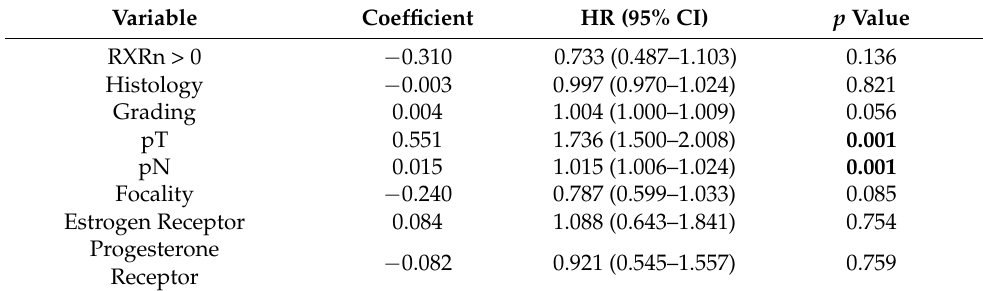
Table 3. Multivariate Cox regression analysis of nuclear RXR α expression in relation to